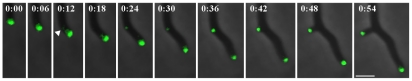
Evidence of tip-focus splitting, growth of foci and emergence of branches, in fluorescence-imaged Streptomyces coelicolor expressing divIVA-egfp.The tip always contains a large DivIVA focus and established tips extend at an approximately constant speed. At about 12 minutes, the DivIVA tip-focus undergoes splitting, leaving behind a new focus (arrow). As the tip continues to extend, the new focus remains in place on the membrane and grows in intensity. After about 42 minutes a new branch is formed at the position of the new focus, with the new focus now sitting at the tip of the new branch. Both the new branch and the original branch now continue to extend in length. Time in hours∶minutes. Scale bar: .